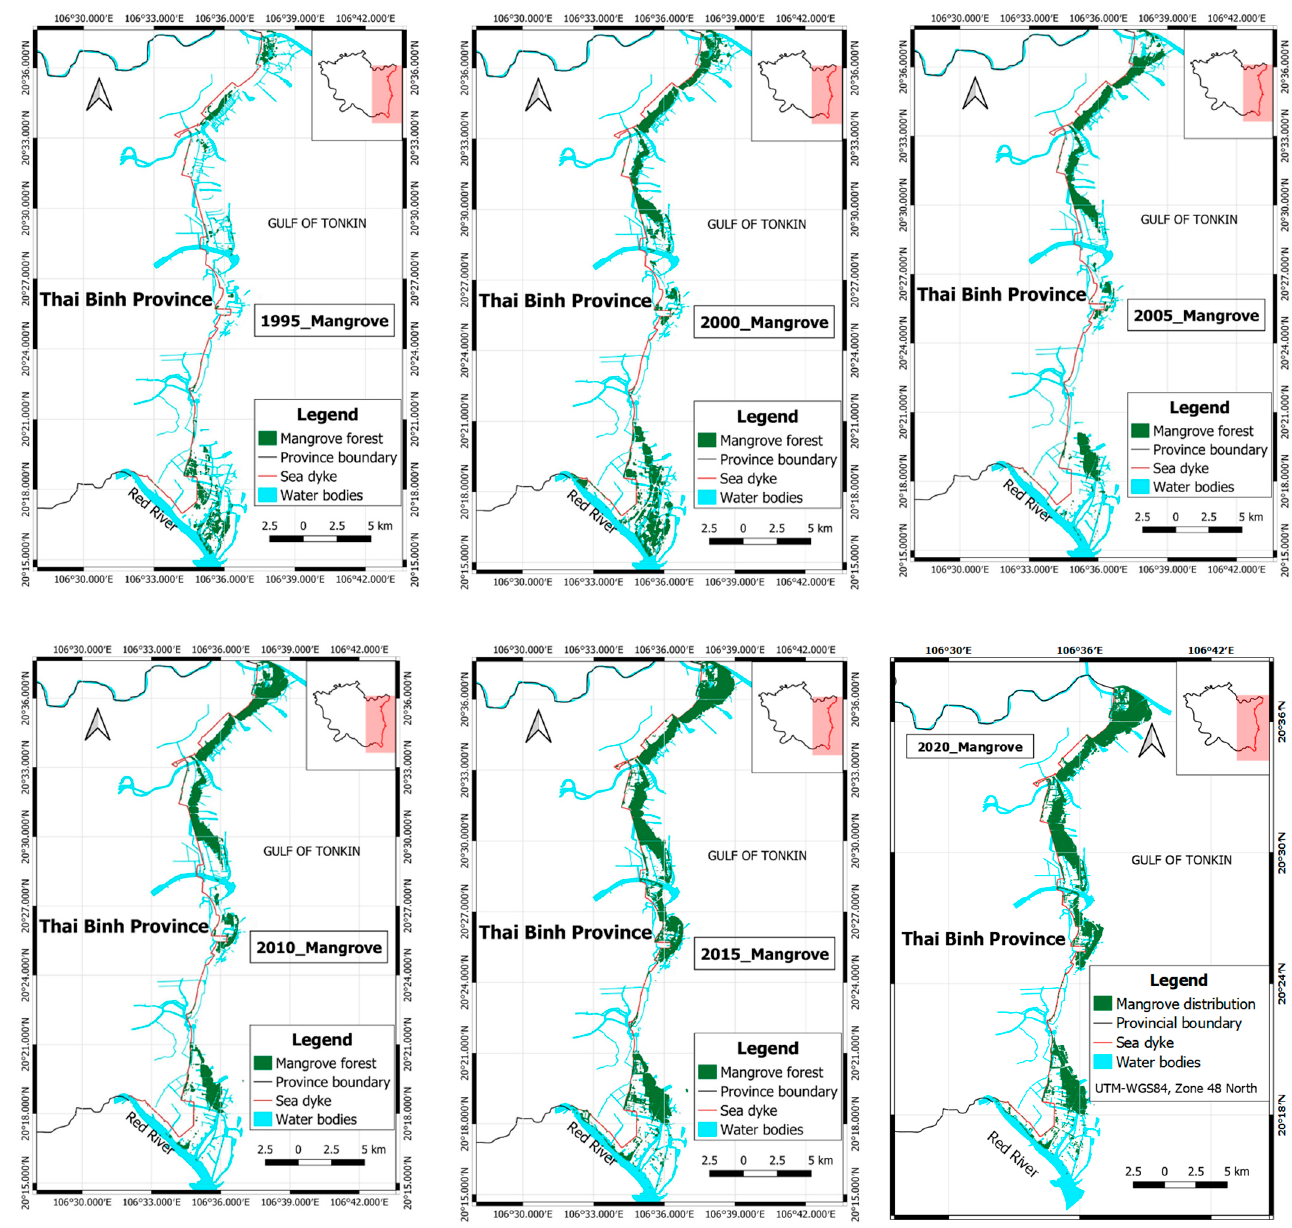
Figure A2. Mangrove distribution maps in Thai Binh between 1995 and 2020.